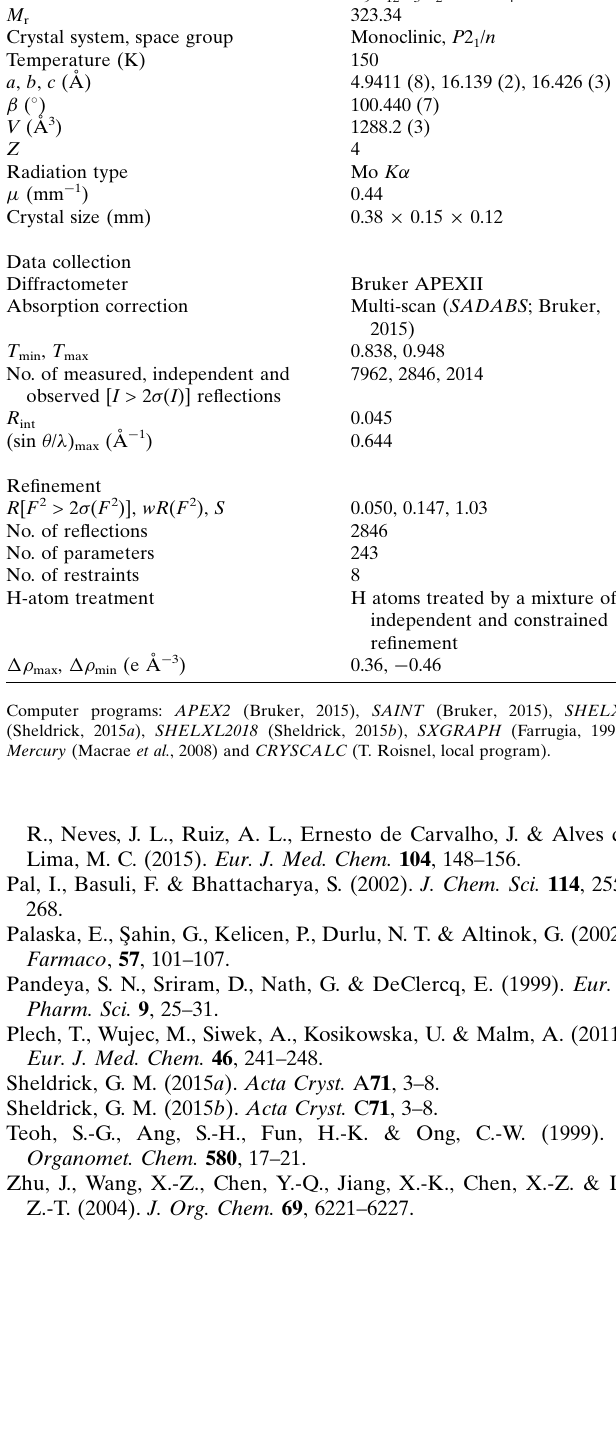
Crystal data Chemical